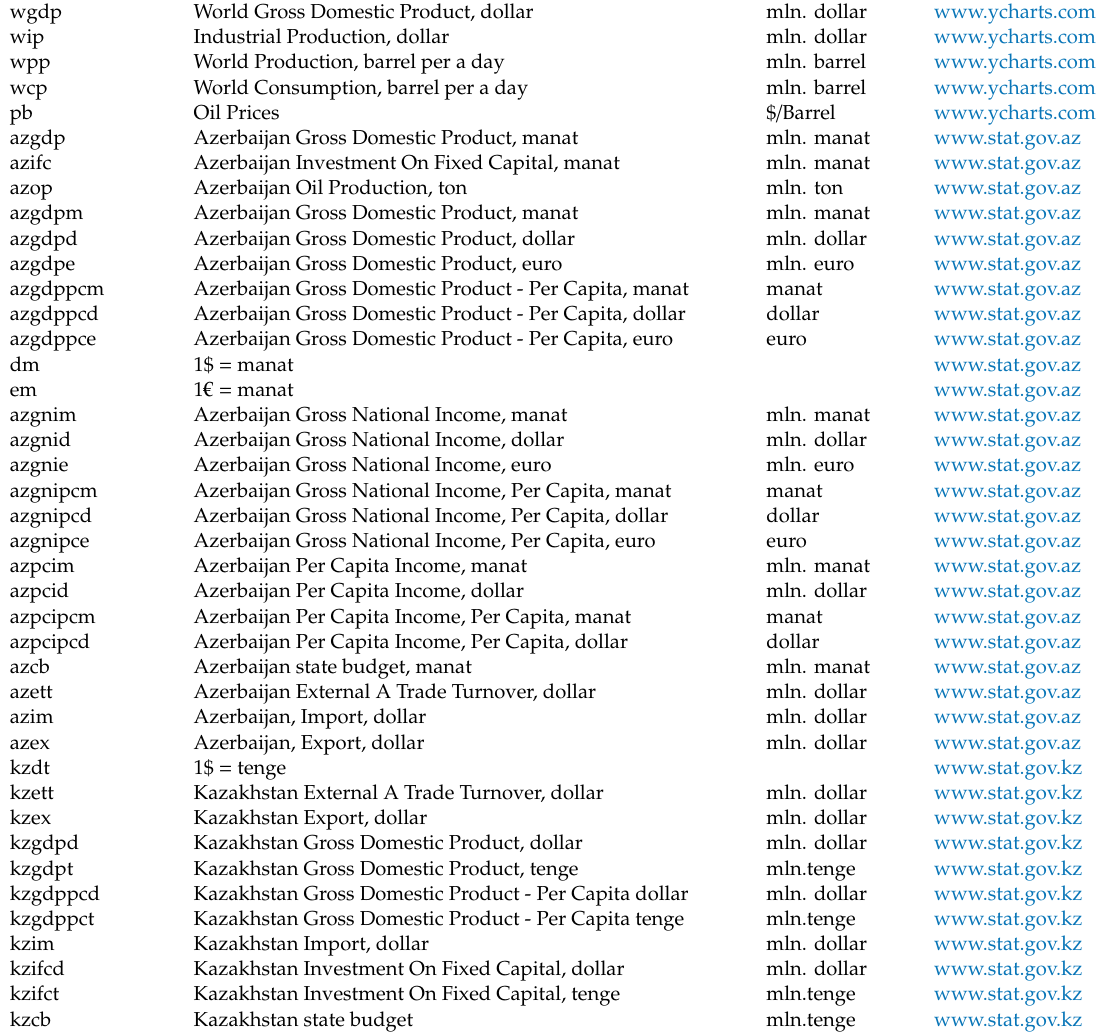
Table A1. Abbreviations and internet resources.